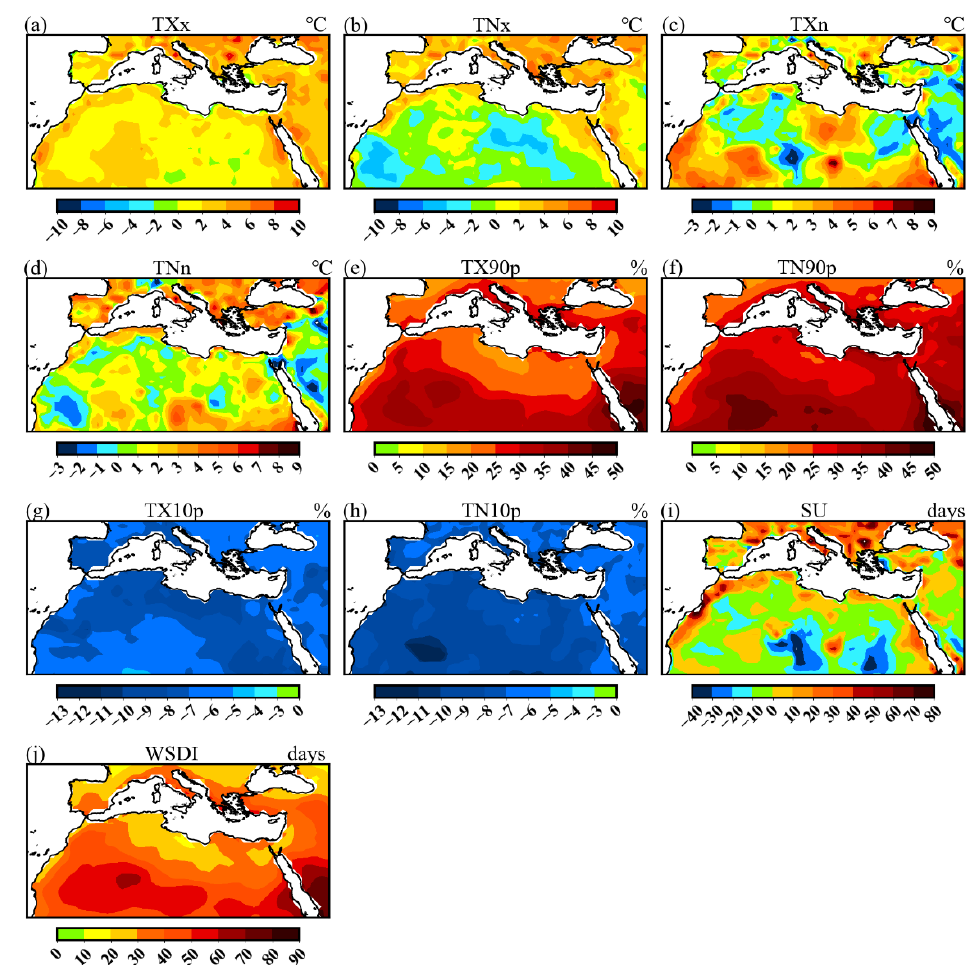
Figure 6. Projected changes in extreme temperature from multi-model ensemble mean CMIP6 GCMs bias-adjusted data during the mid-future (2041–2070) relative to the baseline period (1995–2014) for the SSP2-4.5 scenario. The indices reflect the intensity (TXx, TNx, TXn and TNn) ( a – d ), frequency (TX90p, TN90p, TX10p, and TN10p) ( e – h ) and duration (SU and WSDI) ( i , j ) of the extreme events.